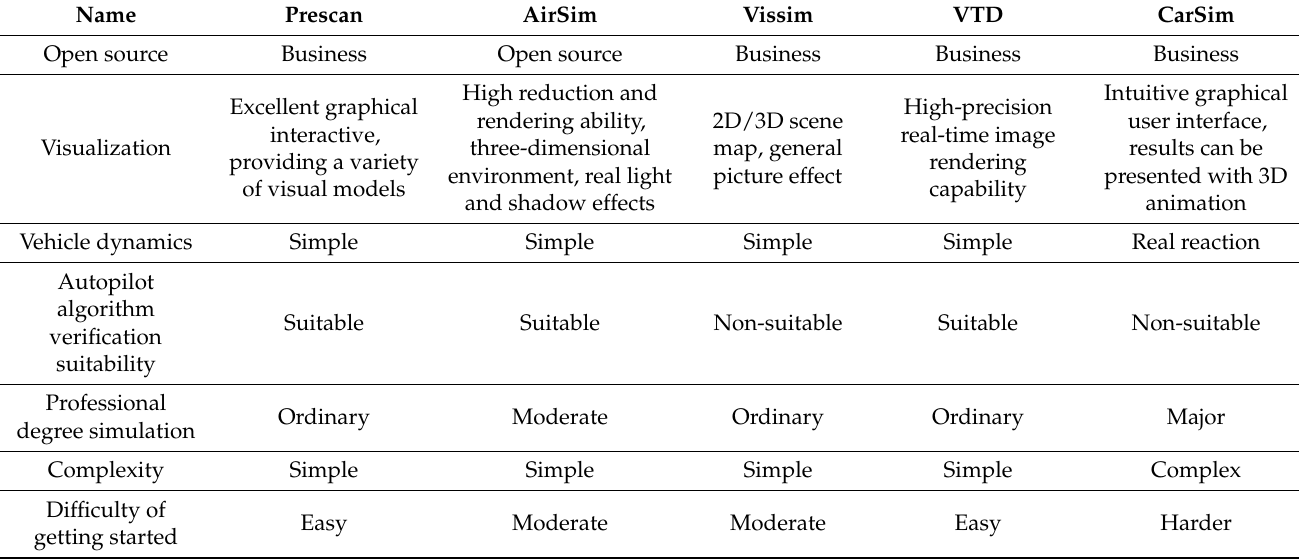
Table 4. Comparison of autonomous driving simulation